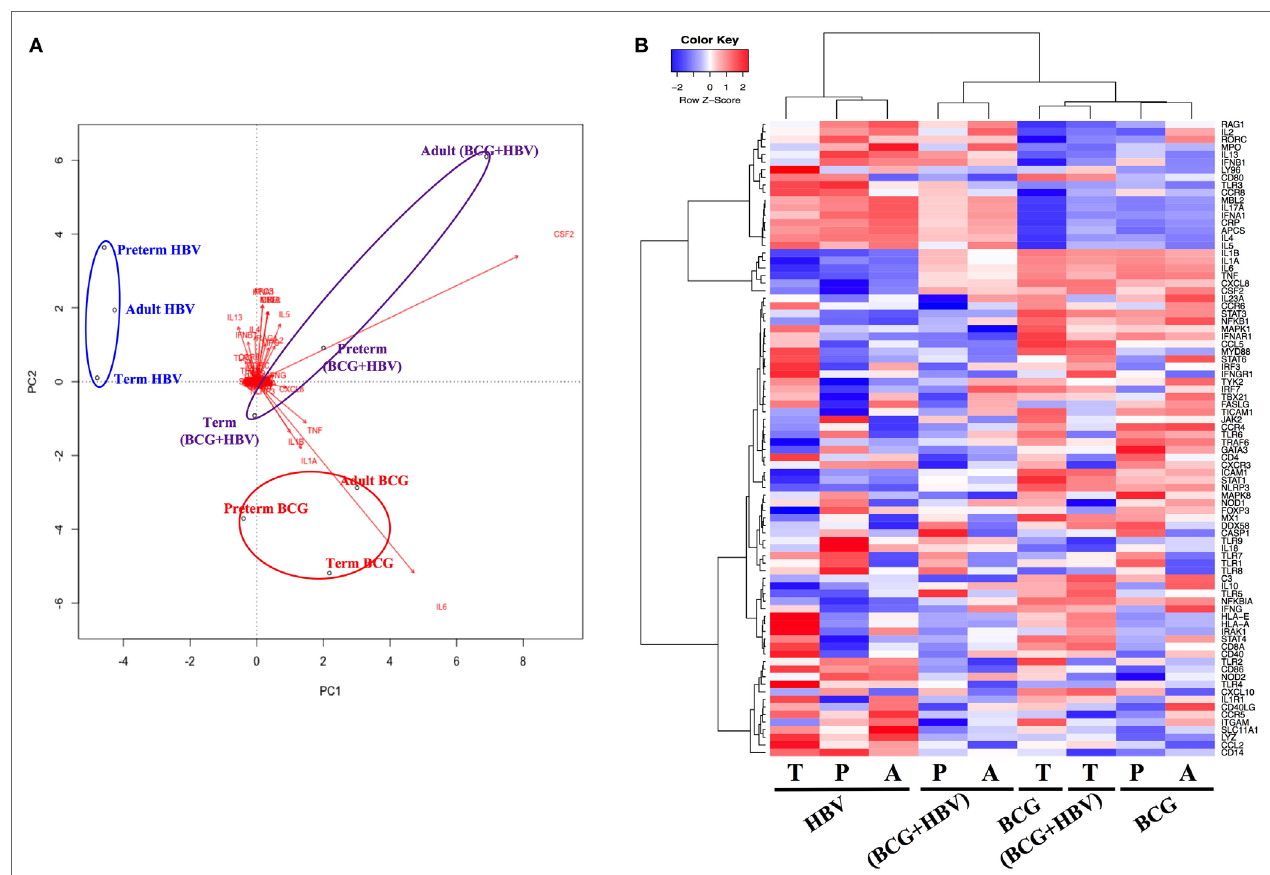
FigUre 4 | Principal component analysis of gene expression data reveals treatment-specific segregation of different age groups. Gene expression data were generated as outlined in Figure 3 . (a) Principal components analysis biplot of mRNA gene expression data where observations (samples) are points and gene expression profiles are arrows shows dominant clustering of profiles by treatment. The distance between points approximates gene expression pattern differences among groupings. Arrows indicate genes that have greater biplot scores and drives the differences between groups. Arrowheads close to a particular group indicate genes are expressed at a greater relative abundance differences in those samples. (B) Unsupervised hierarchical heatmap shows clustering of treatments demonstrating log2-fold changes, expression values of genes in each sample; red to blue scale represent intensity of fold changes per genes (red indicates up, blue indicates down). Each row means individual gene and each column indicates groupings of age and treatment. P, preterm; T, term; A,